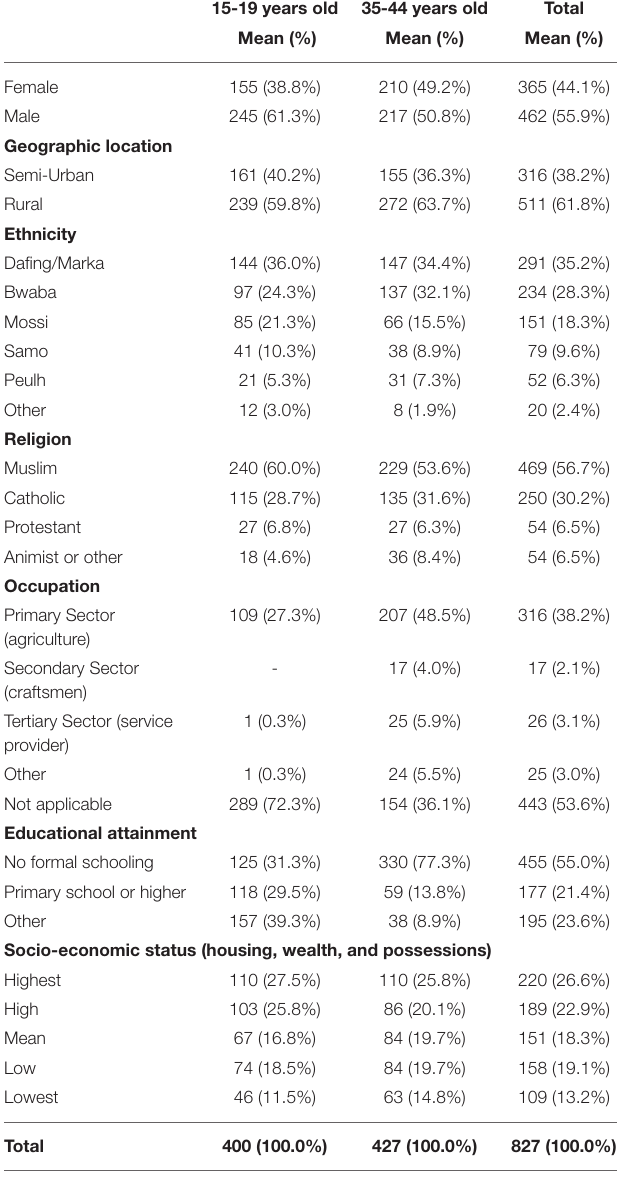
TABLE A1 | Demographic characteristics of the study